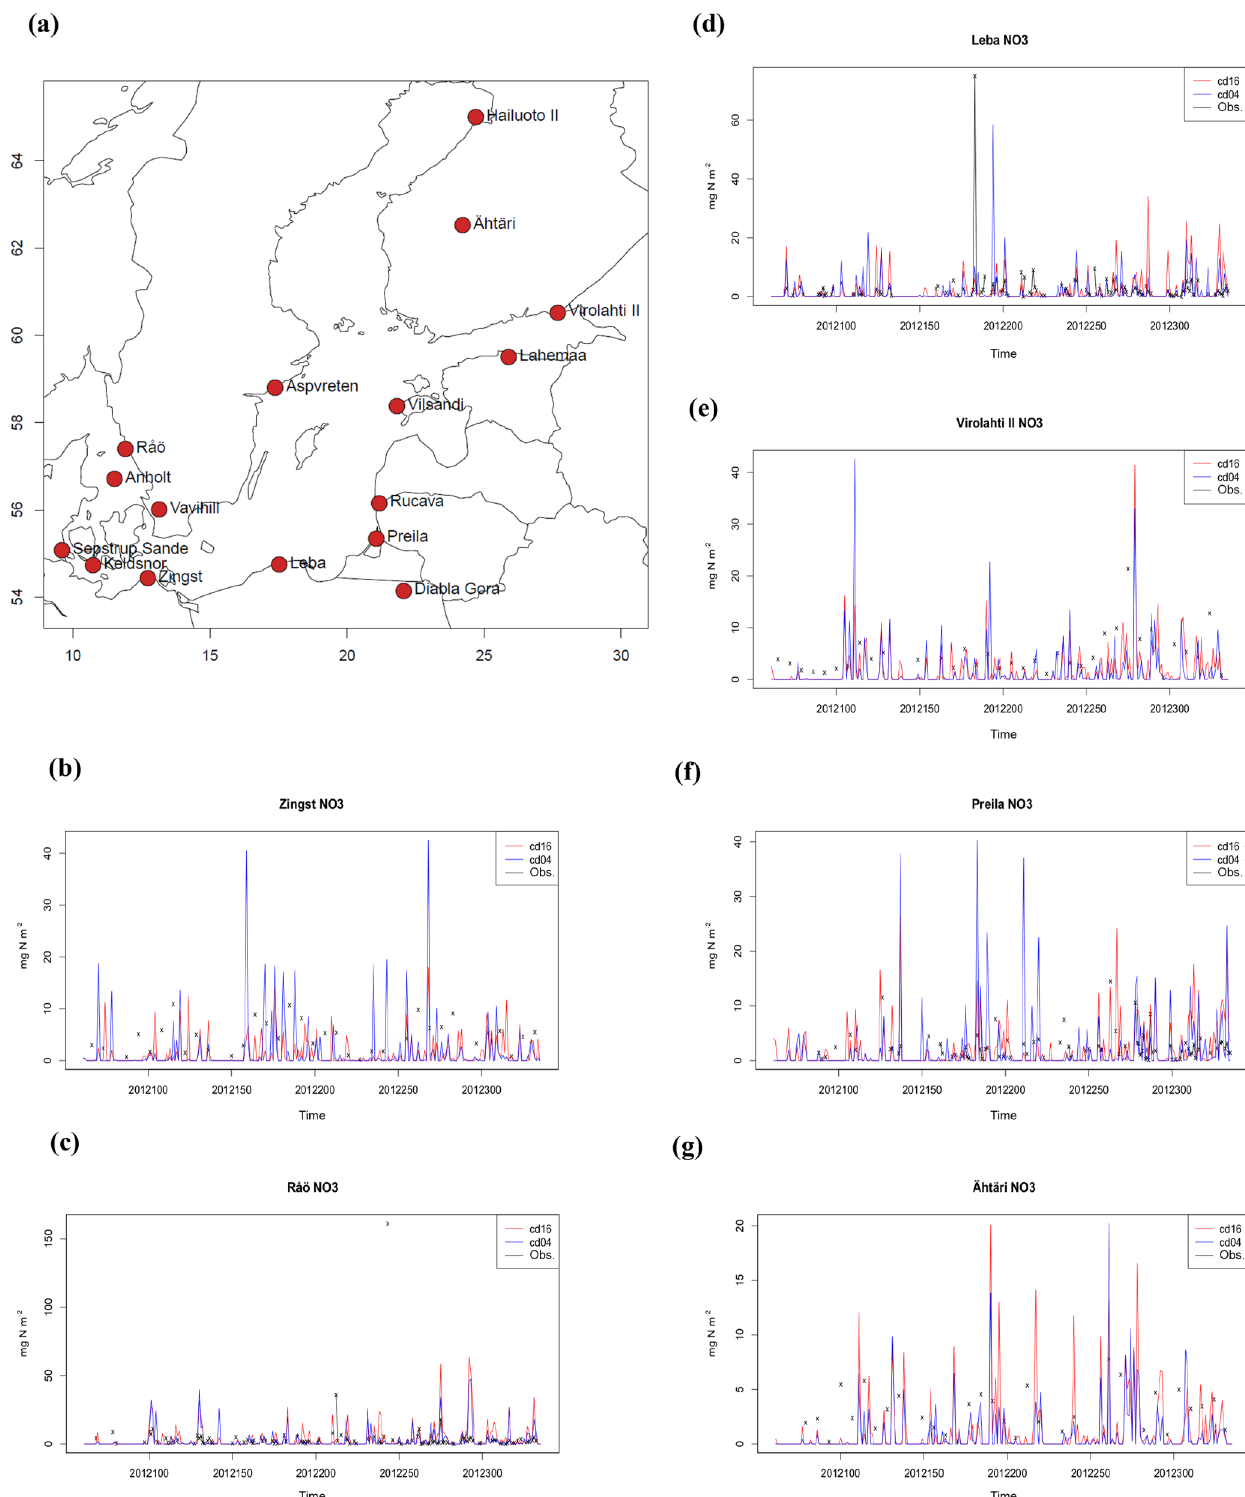
Figure 3. Comparison of modelled wet deposition of nitrate (WNO 3 ) as daily sums (in mg ( N ) m − 2 day − 1 ) from the 16km resolution grid (red) and 4km resolution grid (blue) to observed daily sums (black crosses) at regional background stations around the Baltic Sea from the EMEP monitoring network: (a) map with stations as red circles, (b) Zingst, DE0009R, (c) Råö, SE0014R, (d) Leba, PL0004R, (e) VirolahtiII, FI0017R, (f) Preila, LT0015R and (g) Ähtäri, FI0004R. Comparison time period: 1 March to 30 November 2012. All available data from simulations and observations are